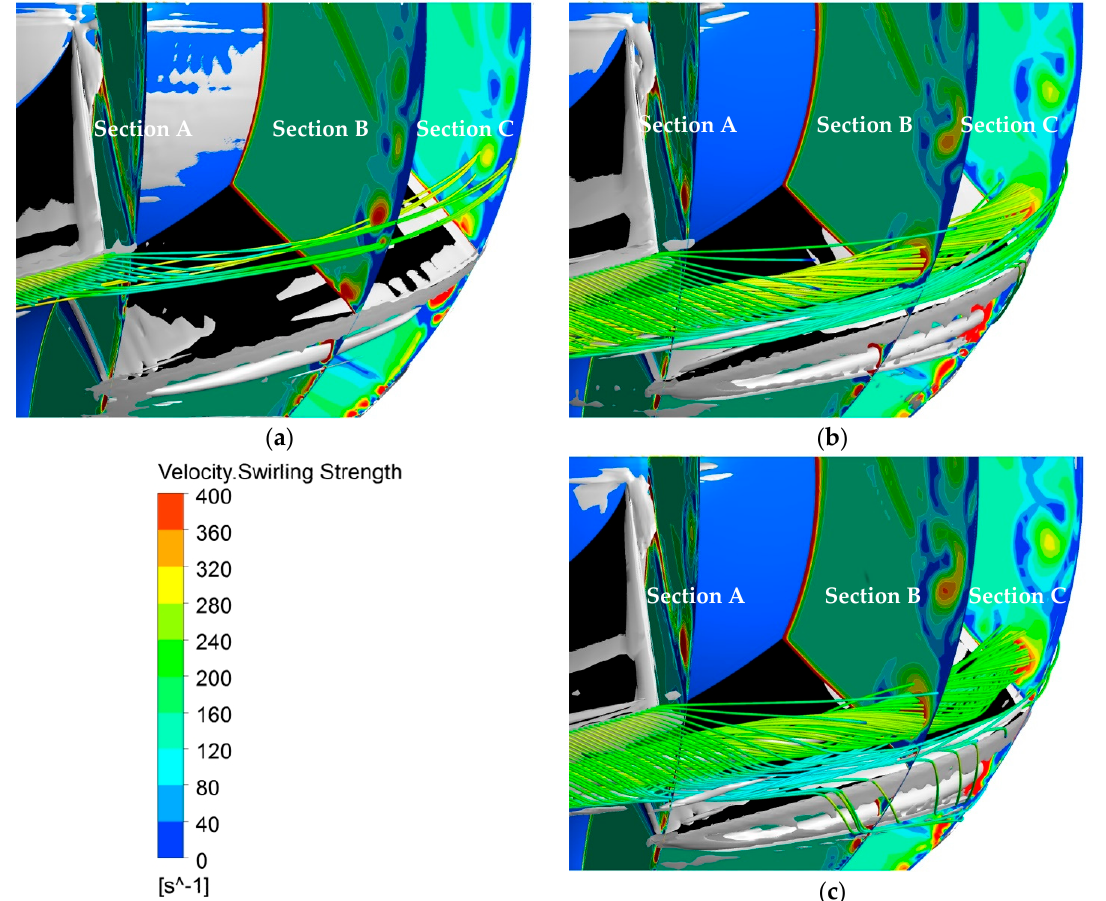
Figure 9. Streamline, velocity swirling strength and vorticity ( Q = 5 × 10 5 s − 2 ) in impeller. ( a ) δ = 0.2 mm; ( b ) δ = 0.65 mm; ( c ) δ = 1.0